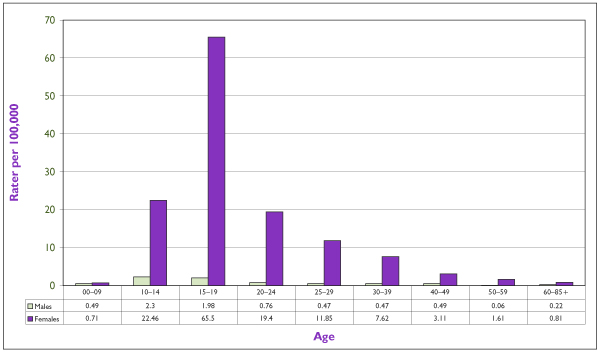
Canadian Inpatient Age-Specific Hospital Separation Rates per 100,000 for Anorexia, Bulimia and Eating Disorders Not Otherwise Specified, 1994–1999 Source: Canadian Institute for Health Information